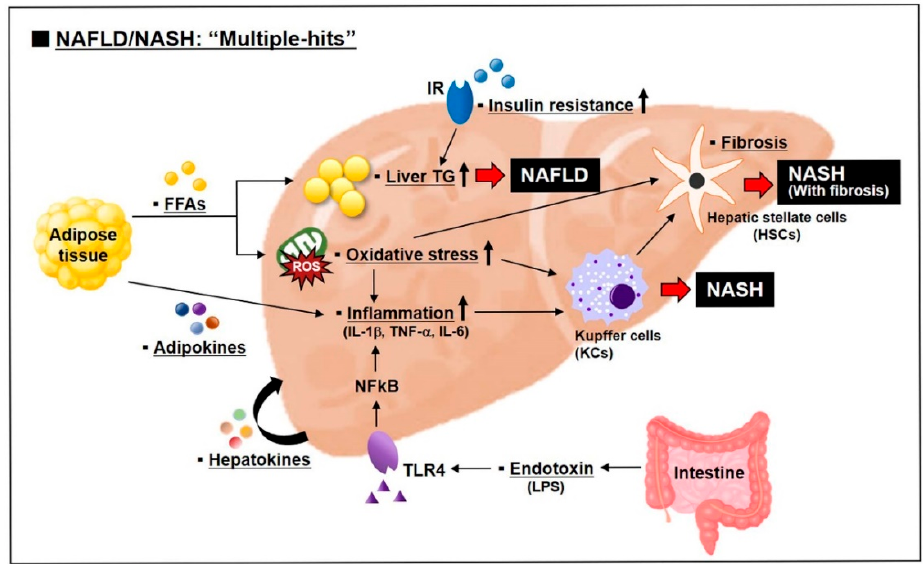
Figure 3. Multiple-hits pathogenesis of NAFLD and NASH. NAFLD begins with hepatic lipid accumulation and insulin resistance, and progresses to NASH with the concert of various factors such as inflammation, endotoxin, organokines (adipokines and hepatokines), and oxidative stress. ( Factors related with